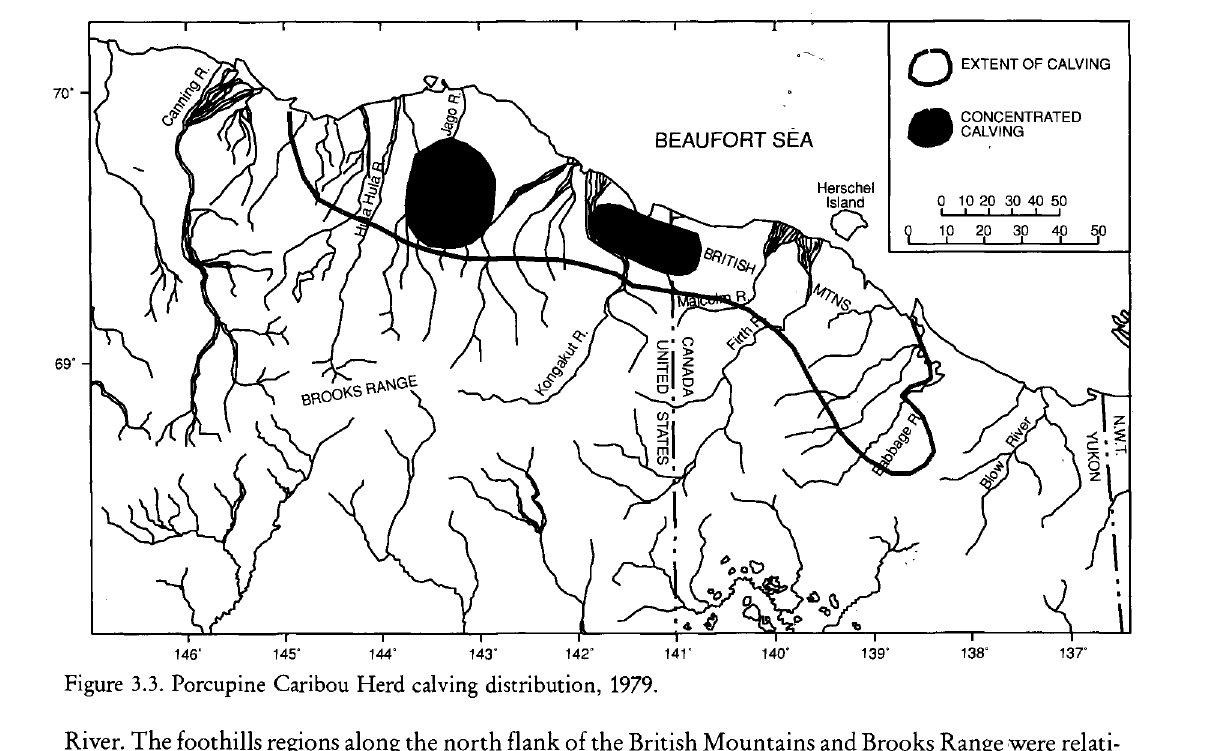
Figure 3.3. Porcupine Caribou Herd calving distribution, 1979. River. The foothills regions along the north flank of the British Mountains and Brooks Range were relati vely free of snow. The extent of calving corresponded closely to the snowfree areas, farther south and east than the usual concentration areas (Russell et al. 1992b). Areas of significant calving included the foothills reaches of the Trail, Crow, Spring and Firth Rivers, across the Fish Creek-Clarence River coastal